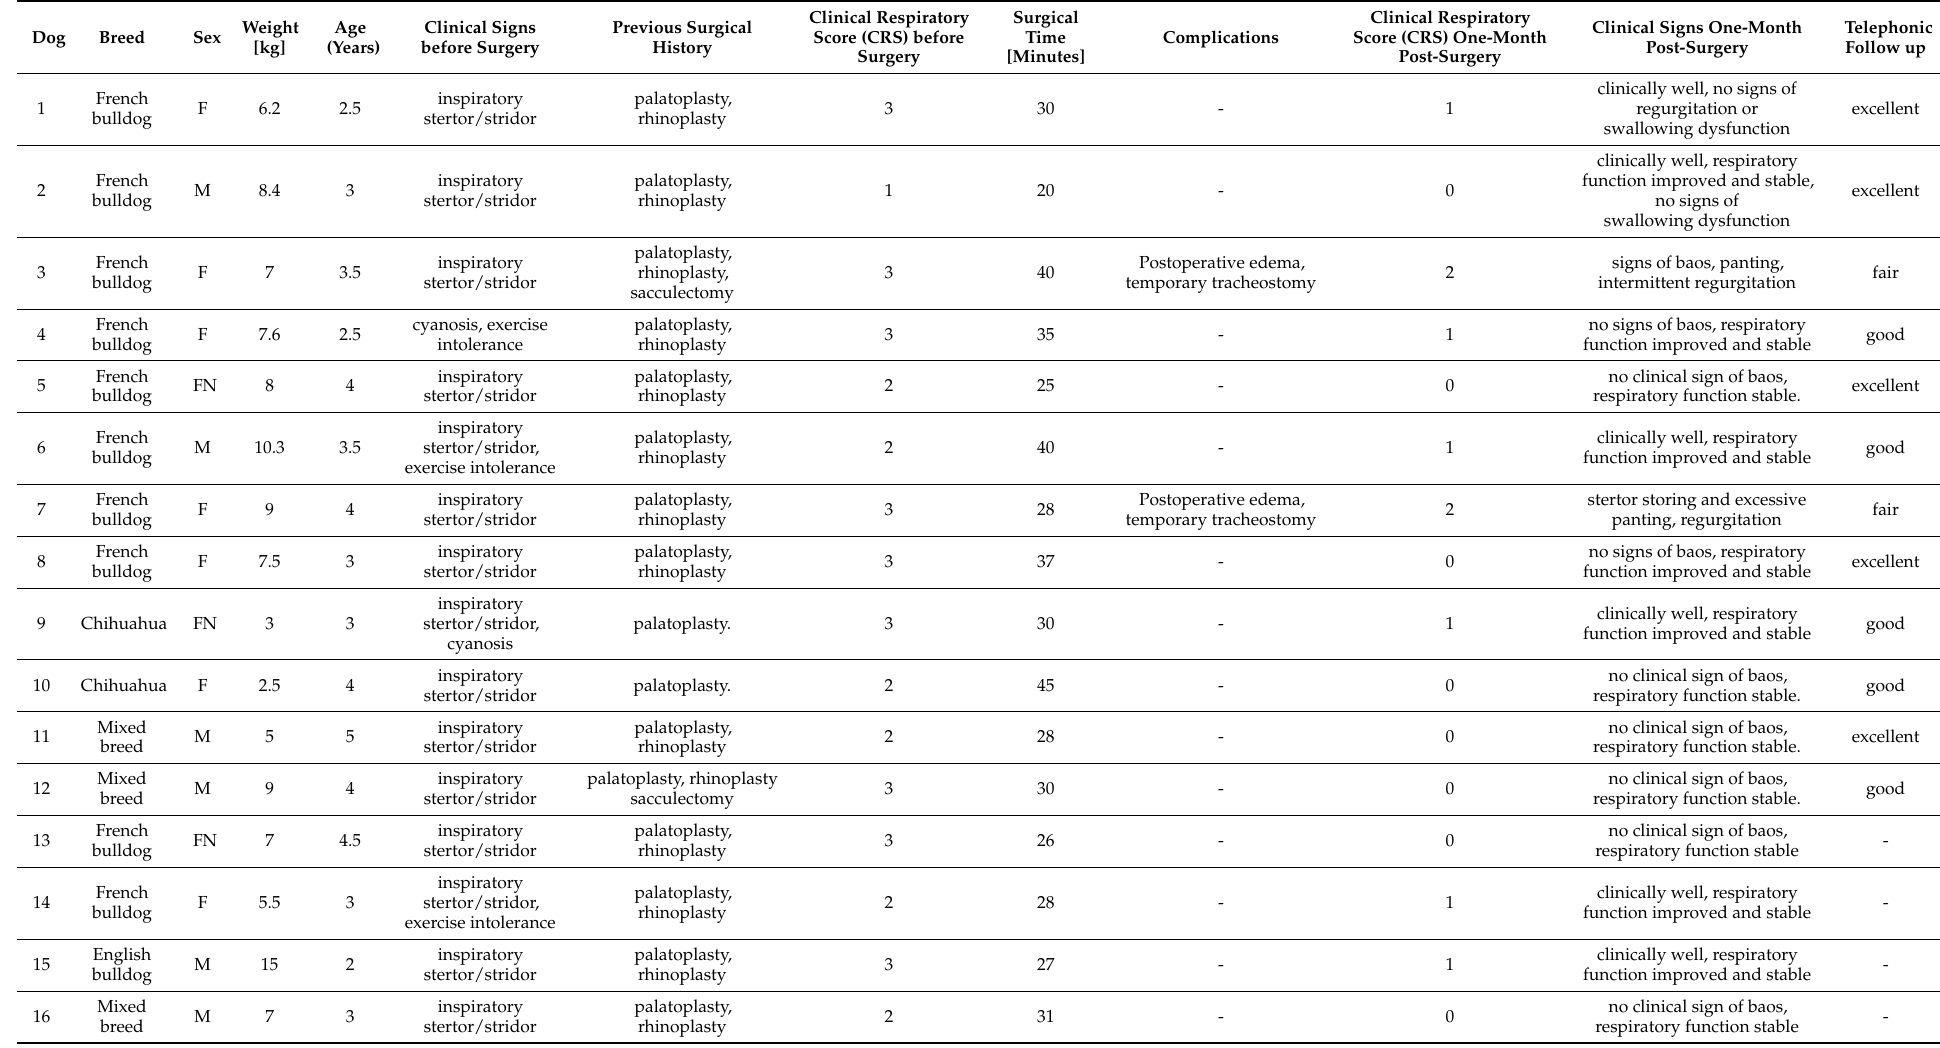
Table 2. Pre- and post-surgery data of the 16 dogs included in the